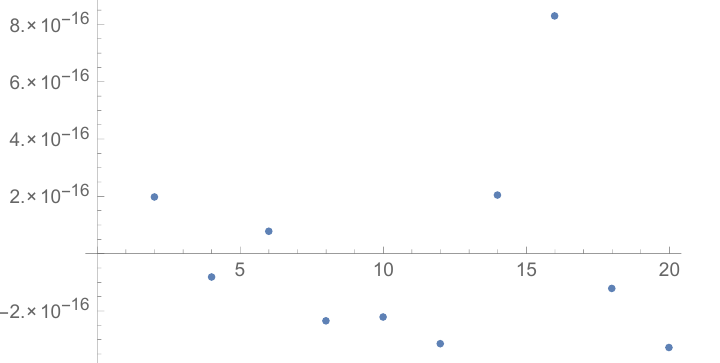
Figure 8. Differences (in N) between the measured Fourier coefficients c m from Figure 7 and the best fit curve c m .